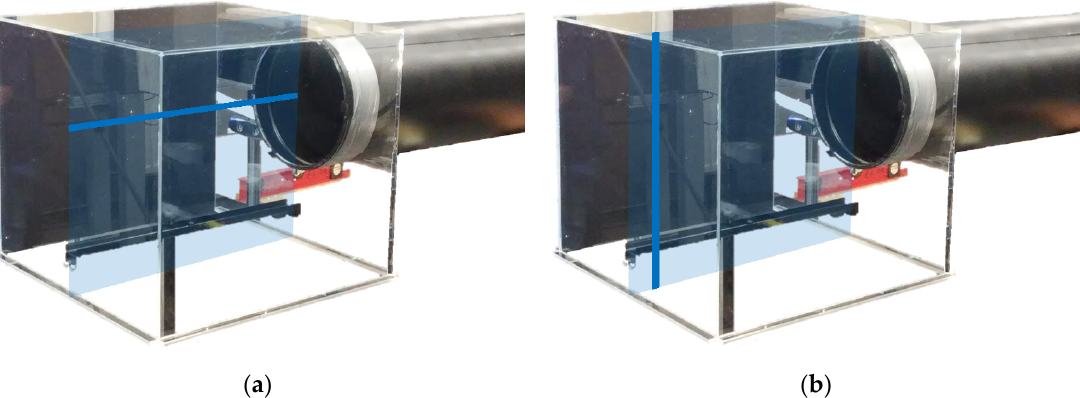
Figure 10. The comparison between numerical results and experimental results was made for line ( a ) Y = 0 mm; ( b ) Z = 350 mm.